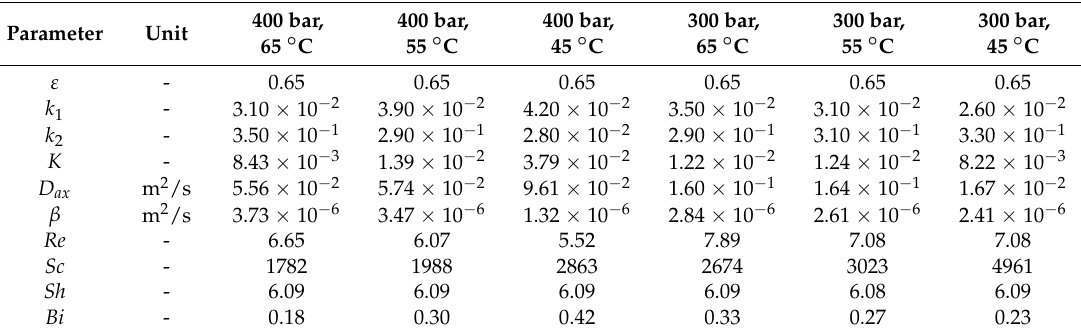
Table 2. Parameters fitted for SFE of palm mesocarp with the VTII model.